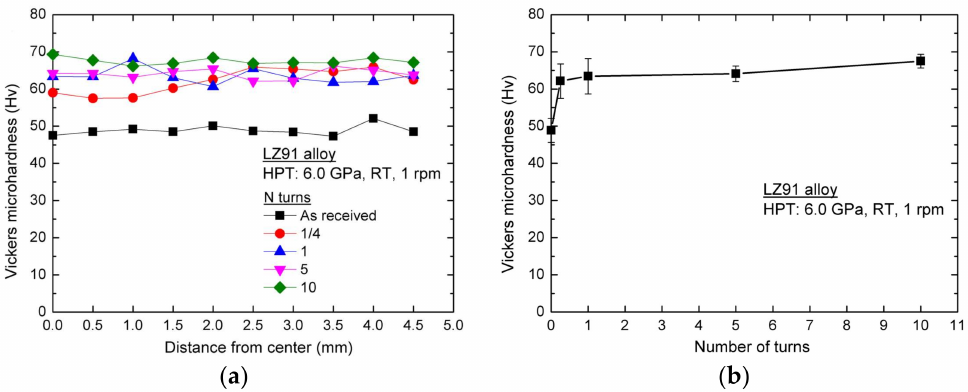
Figure 6. Vickers microhardness of LZ91 alloy ( a ) Along the radius of disk and ( b ) Average values before and after HPT processing with various number of turns.